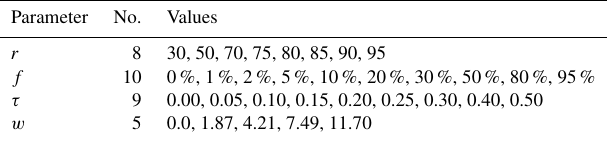
Table 3. Geophysical parameters for which AFRT simulations were performed, for a total of (8 × 10 × 9 × 5) combinations. r is the rel- ative humidity in percent, f is the aerosol fine-size-mode volume fraction, τ is the aerosol optical depth at 865nm, and w is the wind speed in ms − 1